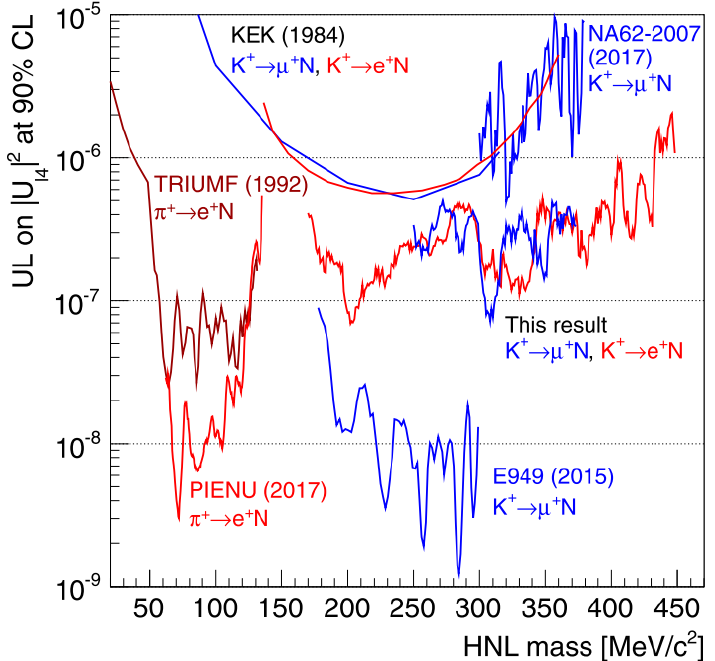
Figure 3. Upper limits at the 90% Confidence Level (CL) on | U l 4 | 2 obtained for each assumed HNL mass, compared to the limits established by earlier HNL production searches in π + decays (TRIUMFand PIENU) and K + decays (KEK, E949 and NA62-2007)